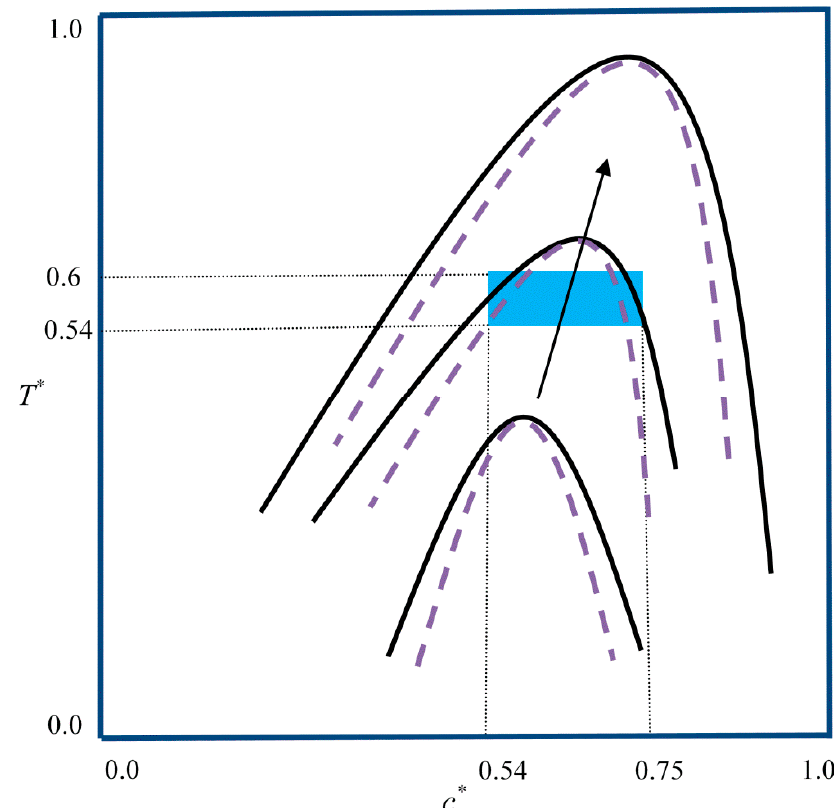
Figure 1. Schematic phase diagram of a binary mixture undergoing the polymerization-induced phase separation (PIPS) phenomenon. The symmetric phase diagram represents the initial state when the degrees of polymerization of both of the components are one. The phase diagram shifts upward to higher concentrations and becomes asymmetric with increasing polymer molecular weight through polymerization. Eventually, the sample is thrust into the unstable region and starts to phase separate. The blue box represents the domain in which all of the eight cases presented in this paper are located.